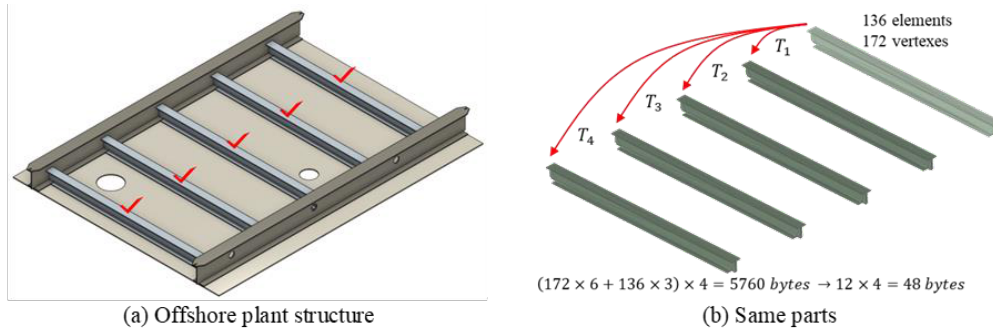
Figure 6. Data size minimization for the same type part.